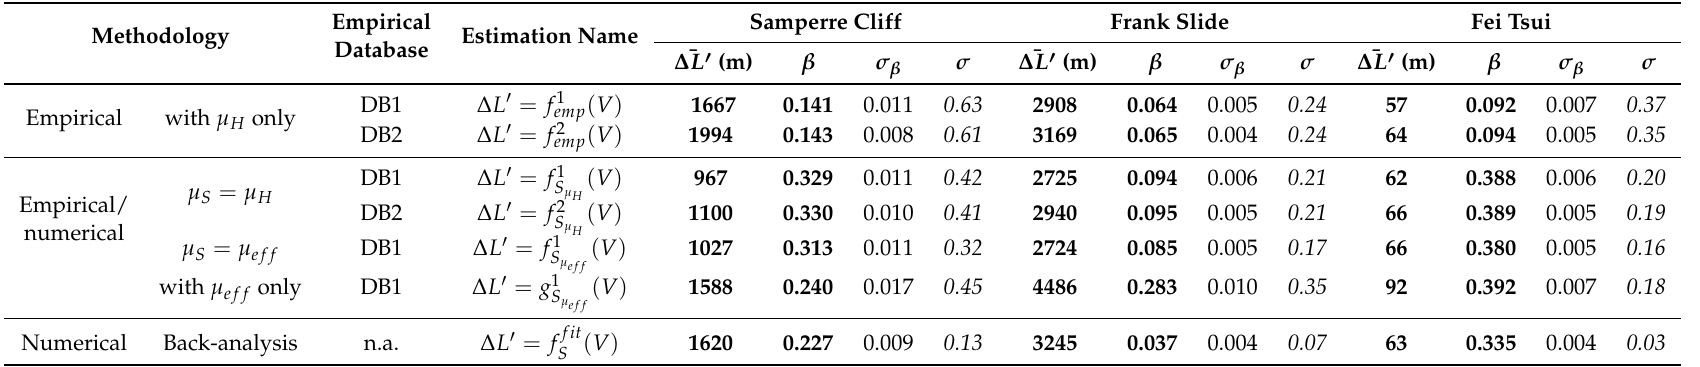
Table 2. Estimations of travel distance ∆ L (cid:48) depending on destabilized volume V , following a power law ∆ L (cid:48) = α V β . We give the value of the exponent β along with the standard deviation of its estimation σ β , and the normalized standard deviation σ of the prediction ∆ L (cid:48) see (13) and (14). ¯ ∆ L (cid:48) is the averaged predicted travel distance for volumes between the minimum and maximum volumes used in the simulation databases, in each case